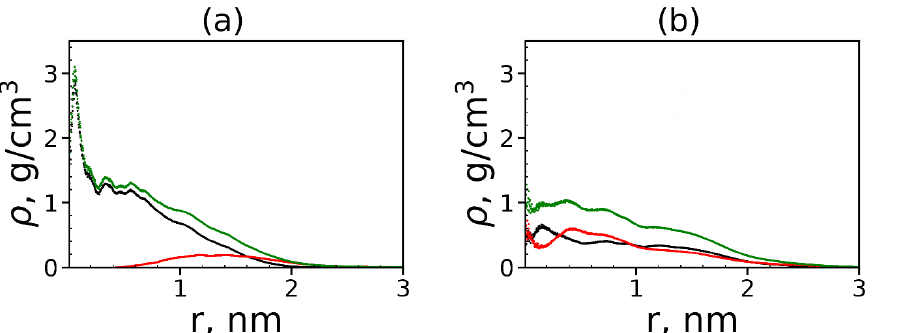
Figure 17. The radial distribution function of the density of: the dendrimer (black), peptide (red) atoms and all atoms in complexes (green) for ( a ) Lys–2His and ( b ) Lys–2Hisp